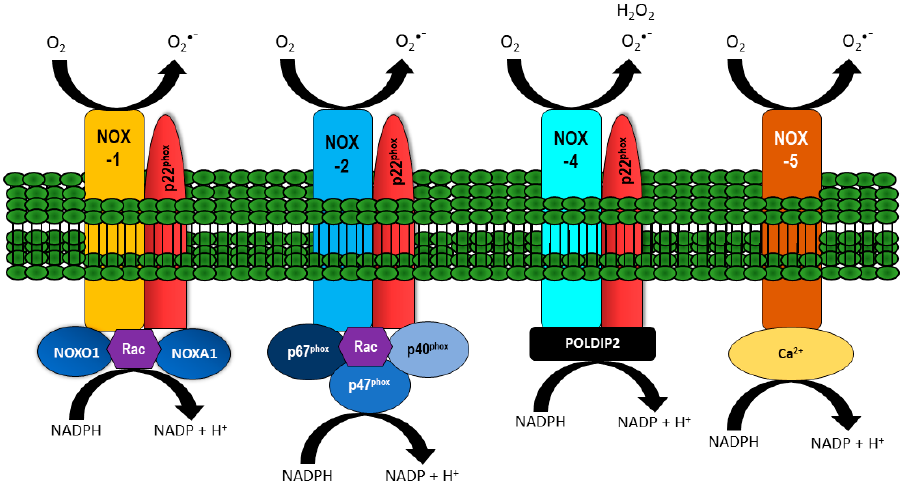
Figure 1. Vascular NADPH oxidase (NOX) and their regulatory subunits. NOX-1, -2, and -4 are localized at the membrane together with p22 phox . The activity of NOX-1 is regulated by NOXO1, NOXA1, and Rac. NOX-2 activity is dependent on binding p67 phox , p40 phox , p47 phox , and Rac, whilst NOX-4 is constitutively active and can be regulated by polymerase- δ -interacting protein 2 (POLDIP2). NOX-5 activity is influenced by calcium. All NOX isoforms generate O 2 • − , with NOX-4 preferentially producing H 2 O 2 .